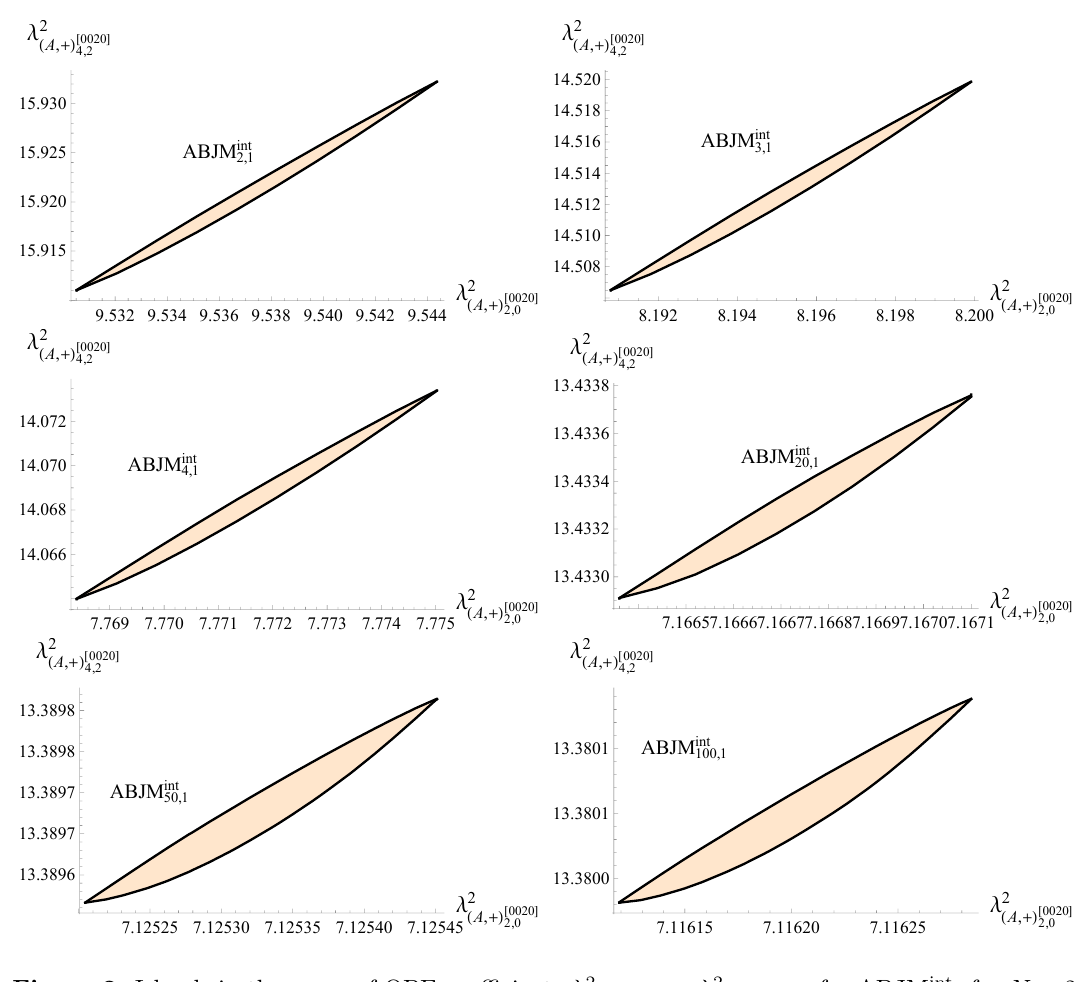
Figure 2 . Islands in the space of OPE coe(cid:14)cients (cid:21) 2